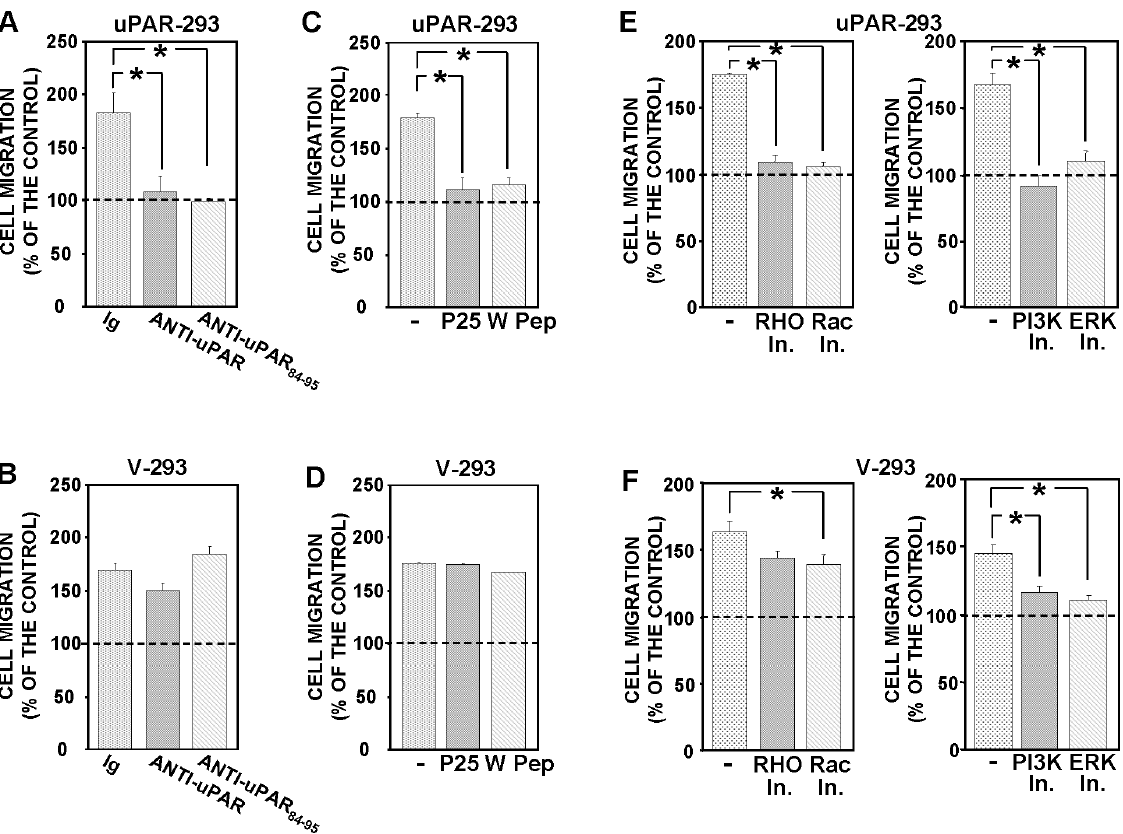
Figure 7. uPAR expression controls cell migration toward EGF. Stably-transfected uPAR-293 cells ( A, C, E ) or V-293 cells ( B, D, F ) were pre- incubated with nonimmune Ig ( - ) or anti-uPAR or anti-uPAR 84–95 polyclonal antibodies ( A and B ), with diluents (-) or P-25 or W (W Pep) peptides ( C and D ), with diluents (-) or inhibitors of Rho- or Rac1-dependent signaling pathways ( E and F, left panels ), with diluents (-) or inhibitors of PI3K or ERK-MAPKs ( E and F, right panels ). Cells were then plated in Boyden chambers and allowed to migrate toward 100 ng/ml EGF. Migrated cells were fixed, stained with hematoxylin, and counted; results are expressed as percentage of cells migrated towards EGF over the cells migrated without EGF; 100% values represent cell migration in the absence of chemoattractants. The values are the mean 6 SD of three experiments performed in triplicate. (*) p # 0.05, as determined by the Student’s t test.